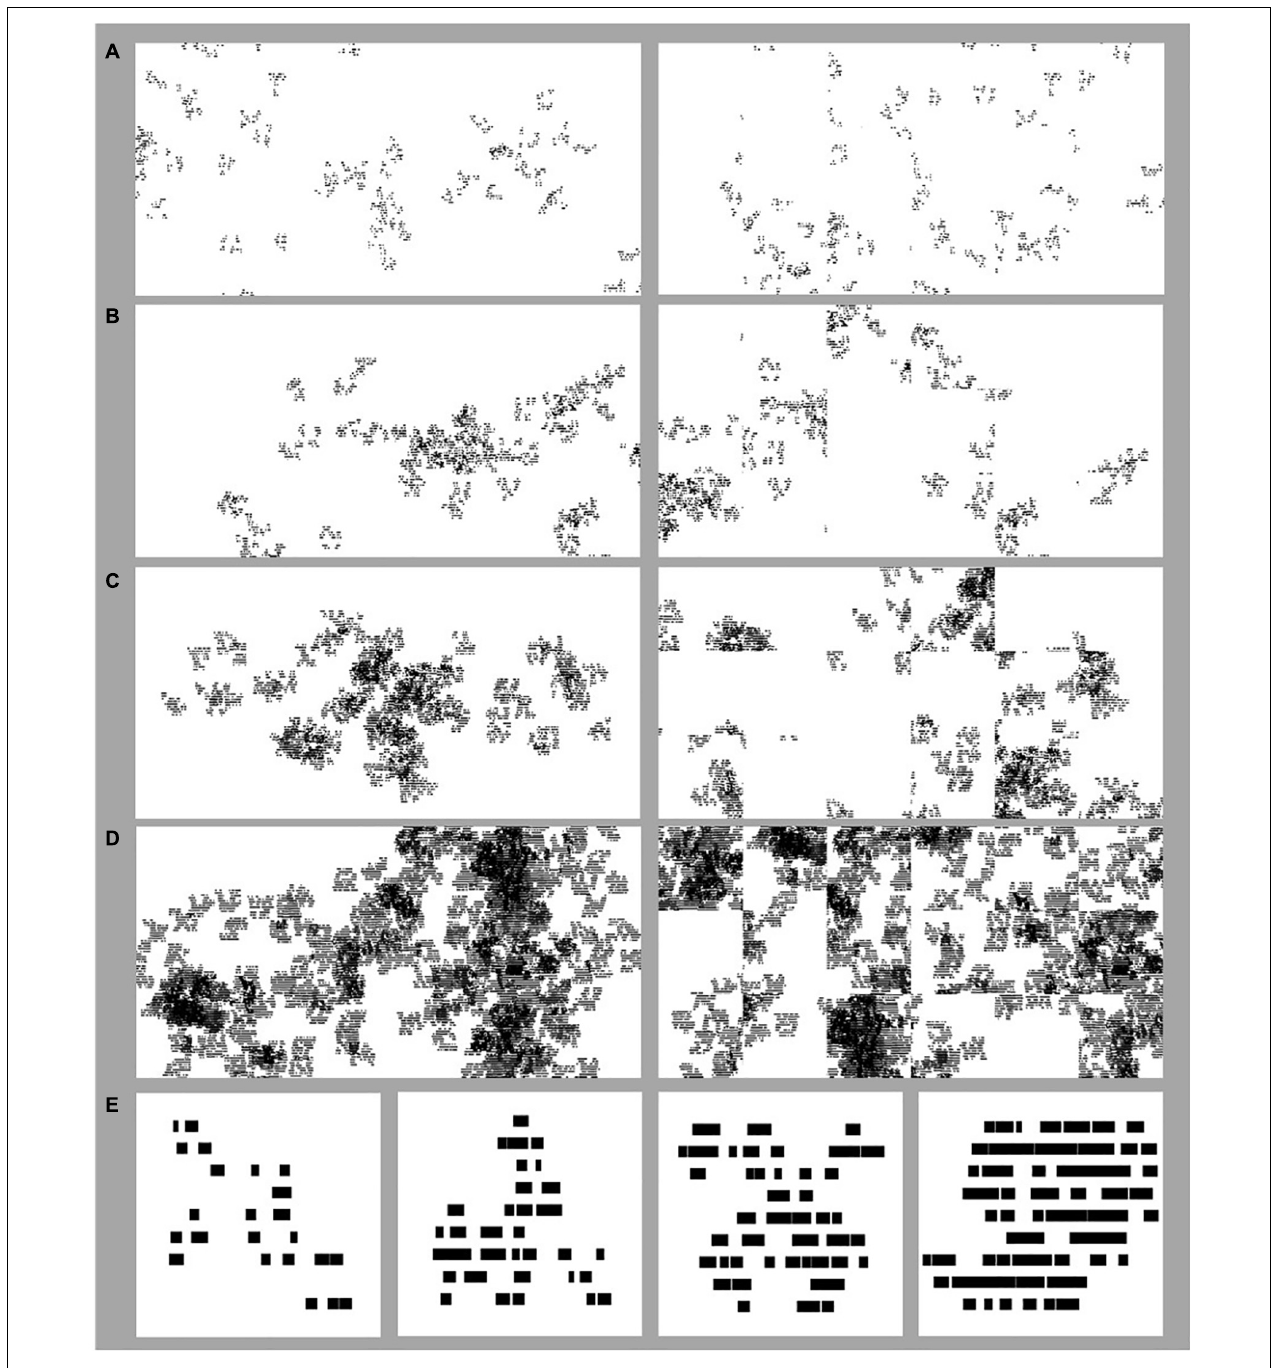
FIGURE 5 | Example stimuli used in the Experiments. Fractal ‘forest’ stimuli used in Experiment 1 of differing D -values where D = 1.2 (A) , 1.4 (B) , 1.6 (C) , and 1.8 (D) . On the left side of each panel in (A–D) are images of the original forest pattern. On the right side of (A–D) are images of randomized versions of the original forest patterns, where the same forest has been divided into tiles and the tiles randomized. Fractal ‘tree’ stimuli used in Experiment 2 (E) of D -values of 1.2, 1.4, 1.6, and 1.8, from the left to right side of the